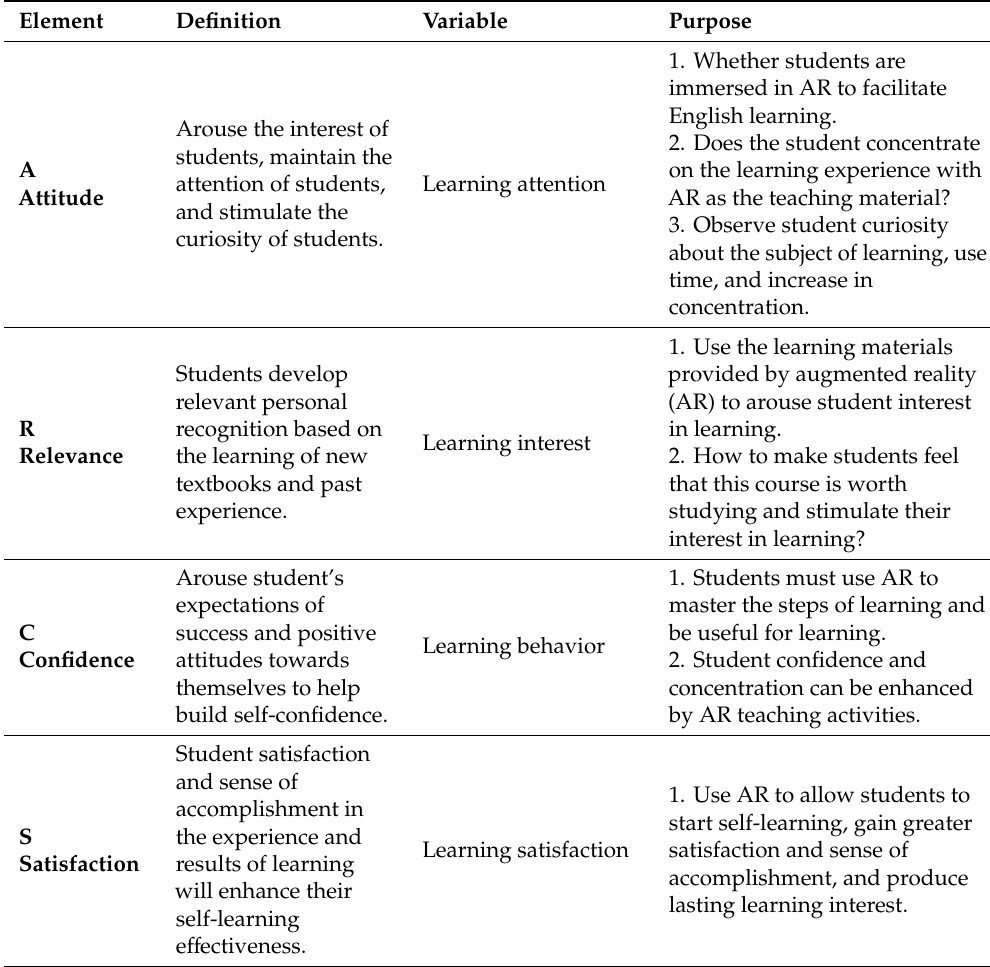
Table 1. Four elements and definitions of attention, relevance, confidence, and satisfaction (ARCS) model, following John Keller’s definitions